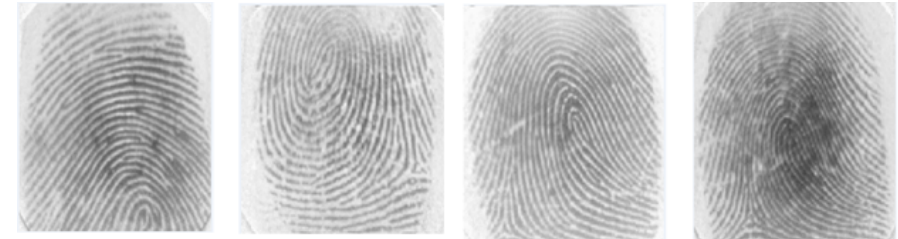
Figure 7. Examples of fingerprint in